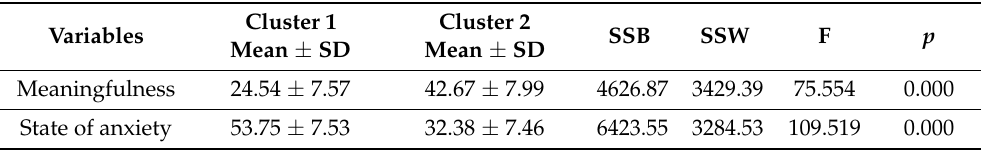
Table 2. Parameters of distribution of clusters’ differentiation in terms of level of anxiety and feeling of meaningfulness ( p < 0.01).